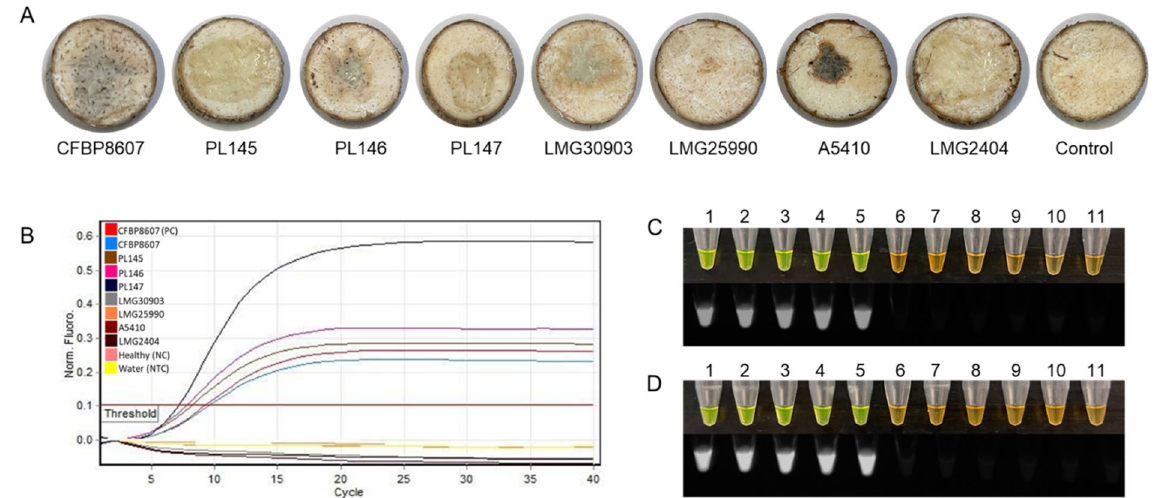
Figure 8. Detection of D. fangzhongdai in artificially infected taro samples. ( A ) Taro slices infected with different Dickeya spp. and a Pectobacterium species; D. fangzhongdai CFBP8607 T , and PL145-PL147, D. undicola LMG30903, D. solani LMG25990, D. oryzae A5410, P. carotovorum LMG2404, and control (healthy taro). ( B ) Sigmoid curve diagram—only D. fangzhongdai infected taro slices were positive, no curve was observed for other Dickeya spp., P. carotovorum LMG2404, NC (negative control; healthy taro) and NTC (non-template control; water). ( C ) Rotor-Gene amplification reactions were used for visualization of the LAMP product by adding SYBR Green I dye. Green: positive amplification, orange: no amplification. Visualization of SYBR Green I dye results under UV exposure–fluorescence indicates positive amplification. ( D ) Dry bath amplification reaction was used for visualization of the LAMP product by adding SYBR Green I dye. Visualization of SYBR Green I dye results under UV exposure. 1–2, D. fangzhongdai CFBP8607 T (purified gDNA and DNA from infected sample); 3–5, D. fangzhongdai PL145-PL147; 6–9 D. undicola LMG30903, D. solani LMG25990, D. oryzae A5410, P. carotovorum LMG2404; 10–11 healthy taro (NC) and water (NTC).